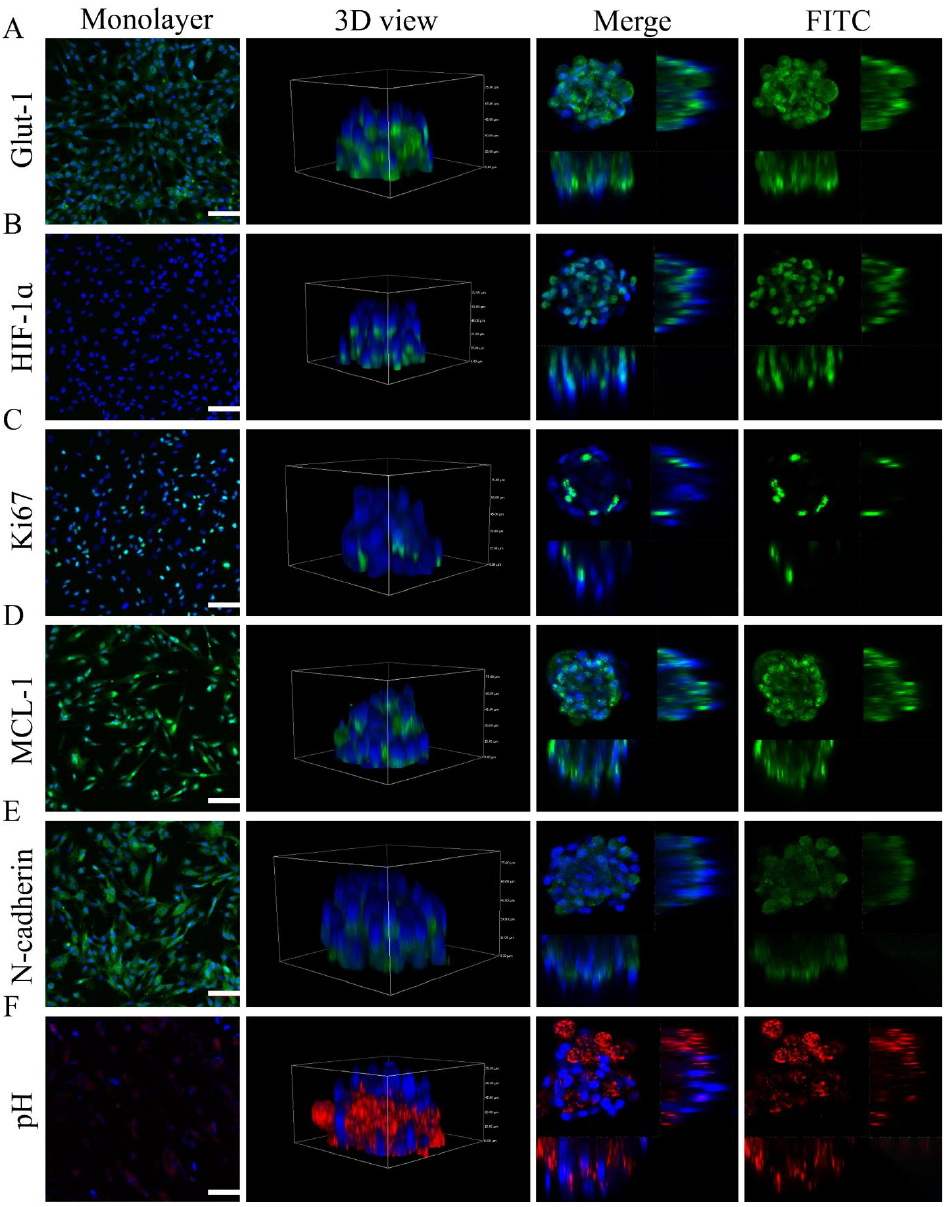
Figure 6. Features of microtumors detected by immunocytochemistry of ( A ) GLUT-1 (specific immu- nity indicator of IH), ( B ) HIF-1 α (hypoxia marker), ( C ) Ki67 (proliferation marker), and ( D ) MCL-1 (antiapoptotic marker) in CD31+ HemEC microtumors and monolayers. Immunocytochemistry of ( E ) N-cadherin in CD31+ HEC microtumors and monolayers. ( F ) Cytosolic pH of CD31+ HemEC microtumors and monolayers. Scale bars = 100 µ